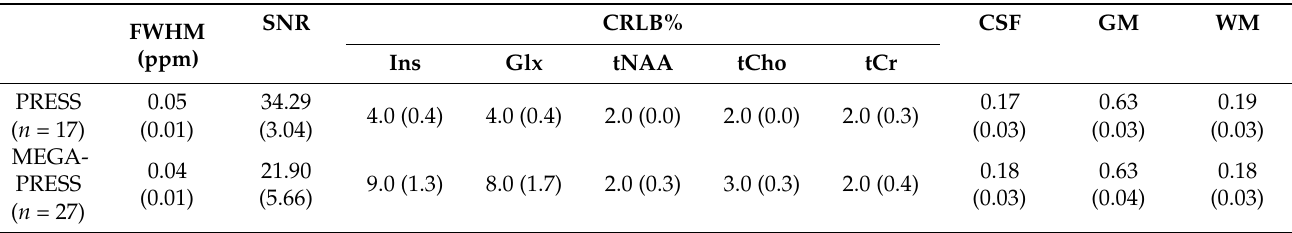
Table 5. Data quality values ((means (standard deviations)): Full-width at half maximum (FWHM), signal-to-noise ratios (SNR), CRLB% for the five metabolites, and voxel composition (fractions of CSF/GM/WM adding up to 1). For GM/WM/CSF, average fractions across days were taken for obtaining